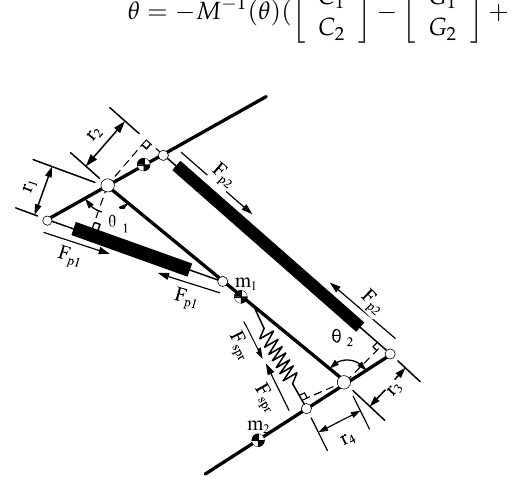
Figure 4. Force analysis of bionic